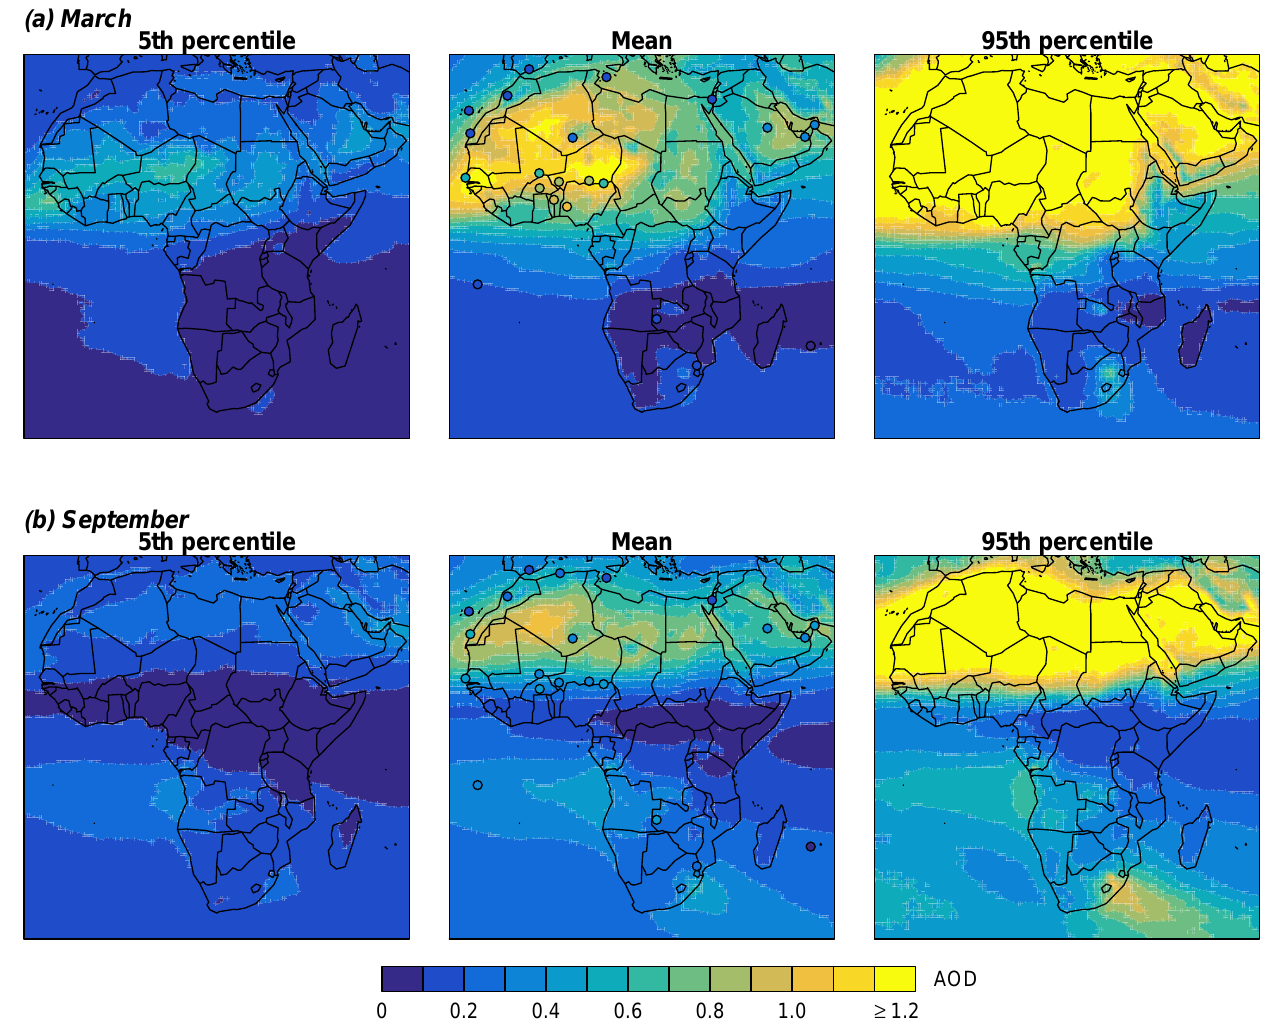
Figure 9. Seasonal variation in multiyear monthly 5th percentile, mean, and 95th percentile modeled AOD 550nm (map background) for the full model climatology (1999–2012), with observed multiyear means (points) for all available AERONET data, for (a) September and (b) March. The number of years and range of years used for each site is the same as in Fig.